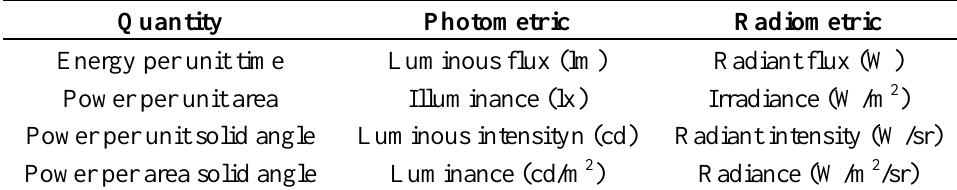
Table 1. General photometric and radiometric